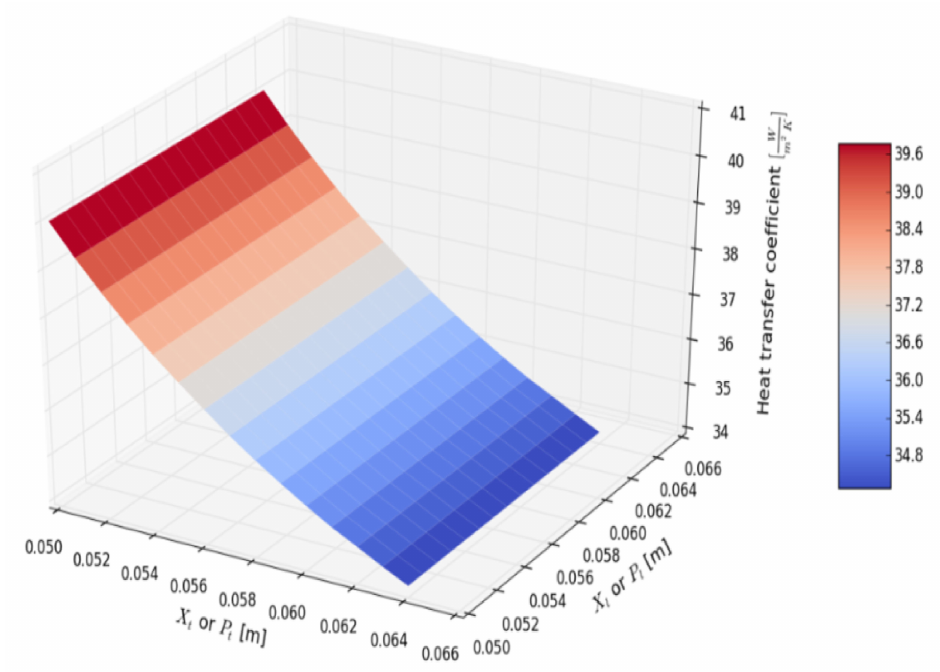
Figure 18. Heat transfer coefficient vs. traversal and longitudinal spacing of the pipes.